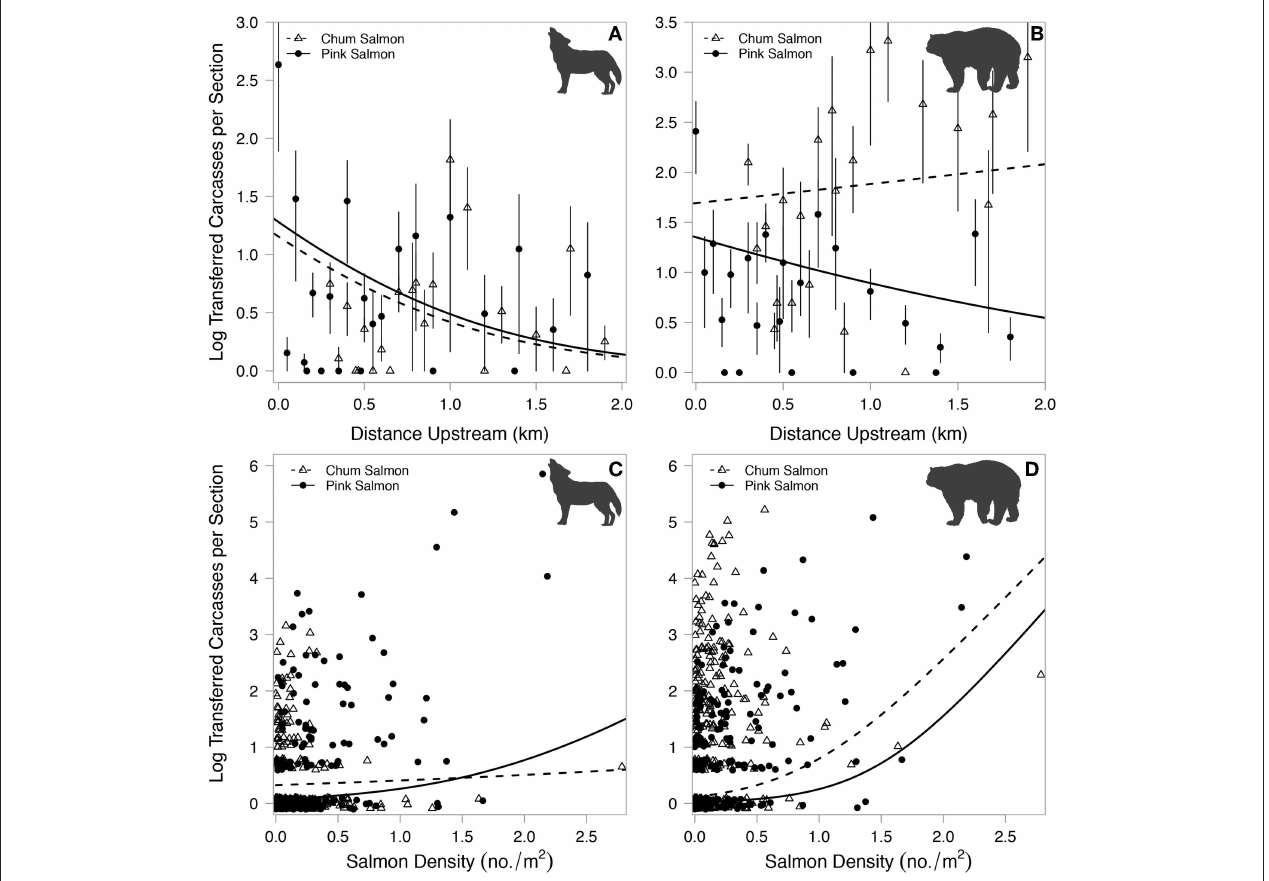
FIGURE 6 | Log-transformed counts of wolf- (A) and bear-transferred (B) carcasses for each salmon species per stream section with increasing distance upstream. Log-transformed counts of wolf- (C) and bear-transferred (D) carcasses for each salmon species per stream section with increasing salmon density. Data points are mean values with 95% confidence intervals for panels (A,B) and raw data points for (C,D) . Lines represent model predictions for each species with all other covariates held at mean values.